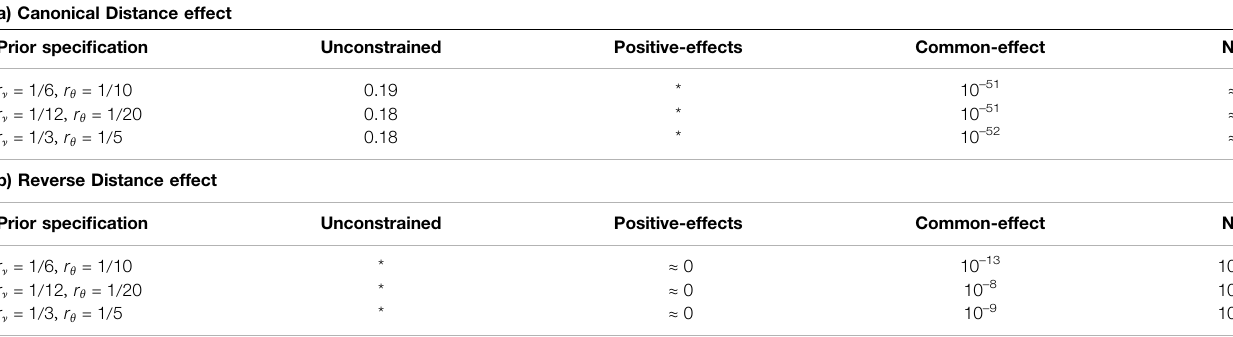
TABLE 3 | Bayes Factor Model Comparisons for (A) the canonical distance effect and (B) the reverse distance